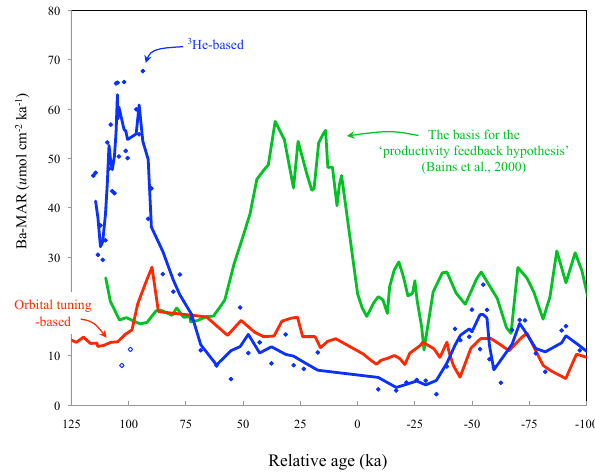
Fig. 4. Ba-MARs vs.age relative to the onset of the carbon iso- tope excursion (CIE). Both the 3 He-based and the refined orbitally- tuned records indicate relatively constant export production during the first ∼ 70ka of the CIE, in sharp contrast to the original inter- pretation by Bains et al. (2000). Thereafter the two new records diverge: while the 3 He-based Ba-MARs display a gradual increase and reach a maximum about ∼ 20ka later, the refined orbitally- tuned age model implies relatively constant Ba-MARs throughout the entire event. Colors pertain to the legend of Fig.